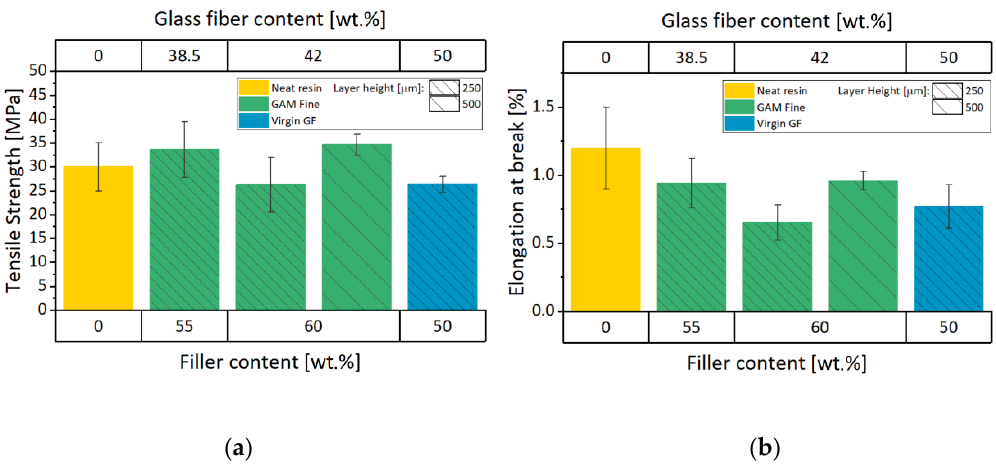
Figure 7. Failure properties of Neat Resin, FIL 100, and GAM Fine-reinforced resins: ( a ) tensile strength graph; ( b ) elongation at break graph.